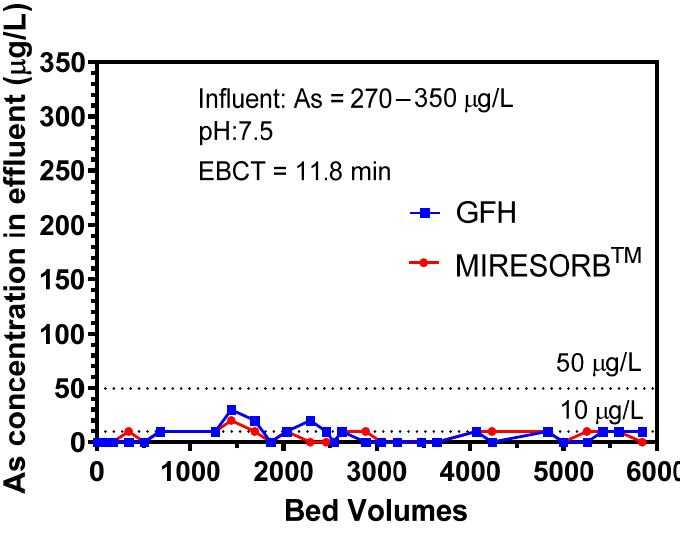
Figure 6. Results from lab-scale column experiments of arsenic adsorption by MIRESORB TM and GFH adsorbents.